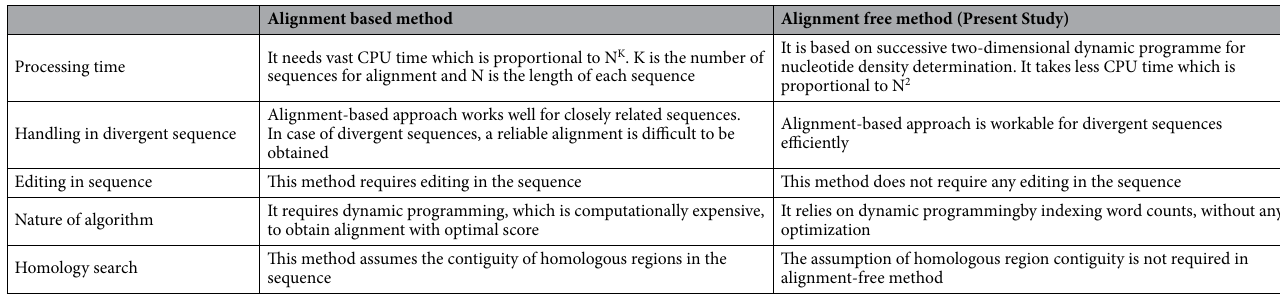
Table 1. Comparison of the alignment-based and alignment-free algorithm (present